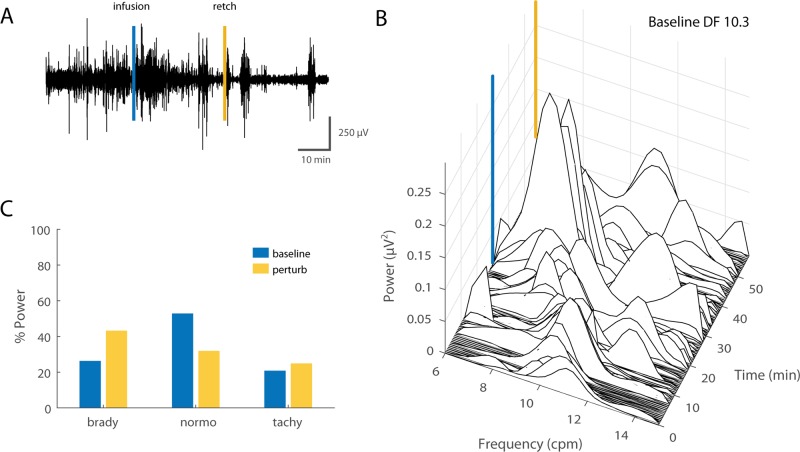
GI myoelectric activity recorded during emetine infusion in an awake behaving ferret.A) Example of a 90 min filtered and downsampled GI myoelectric recorded from segment 1 of an awake behaving ferret during an emetine infusion trial. Emetine induced retch (yellow line) was observed approximately 27 min post infusion (blue line). B) Waterfall plot of the power spectral density for the waveform shown in A leading up to the first retch. Each time window corresponds to the FFT of 1 min of GI myoelectric data. C) Percentage of total power in the 6–15 cpm range partitioned by bradygastric (7.3–9.3 cpm), normogastric (9.3–11.3 cpm) and tachygastric (11.3–13.3 cpm) ranges for a signal with a DF of 10.3 cpm at baseline versus pre-retch.